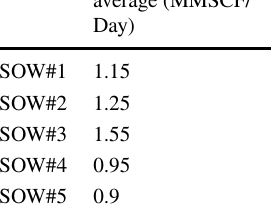
water in each shale oil well in MMSCF/Day during chemical enhanced oil recovery